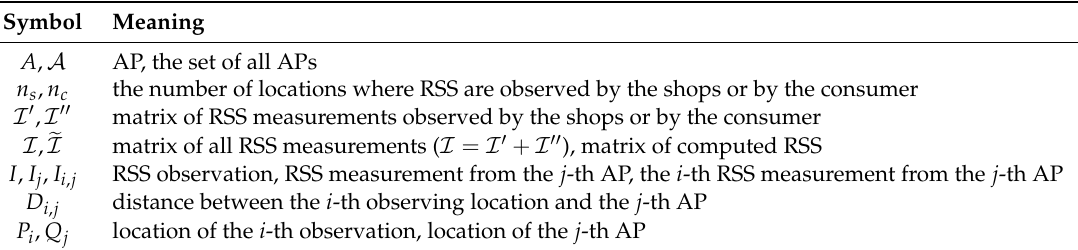
Table 1. Summary of